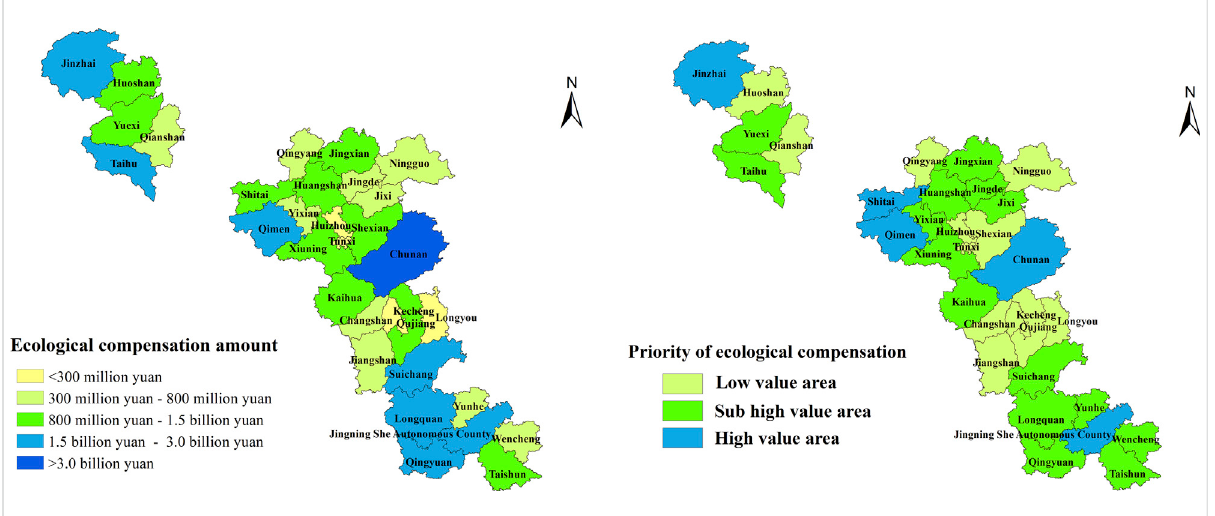
FIGURE 7 EC amount and priority level of counties (districts) in